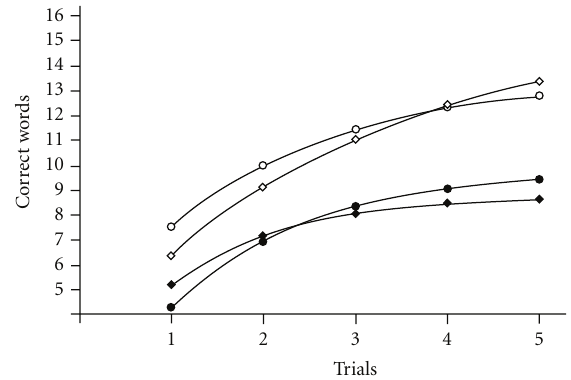
Figure 5: The averaged learning curves over cluster referring to lower memory functioning and cluster referring to higher memory functioning for healthy male participants and MS male patients, using B 3 or B 4. Empty circles—cluster referring to higher memory functioning using B 3 in healthy male participants; B 2 = 0.53; B 3 = 7.50; B 4 = 13.46. Empty diamonds—cluster referring to higher memory functioning using B 4 in healthy male participants; B 2 = 0.34; B 3 = 6.39; B 4 = 15.76. Filled circles—cluster referring to lower memory functioning using B 3 in MS male patients; B 2 = 0.65; B 3 = 4.26; B 4 = 9.81. Filled diamonds—cluster referring to lower memory functioning using B 4 in MS male patients; B 2 = 0.82; B 3 = 5.17; B 4 = 8.74. In healthy male participants, B 3 is higher in cluster referring to higher memory functioning using B 3 ( P = . 04) in comparison with cluster referring to higher memory functioning using B 4. In MS patients, B 3 was higher in cluster referring to lower memory functioning using B 4 ( P = . 0002). However, B 4 was higher in cluster referring to lower memory functioning using B 3 ( P = .